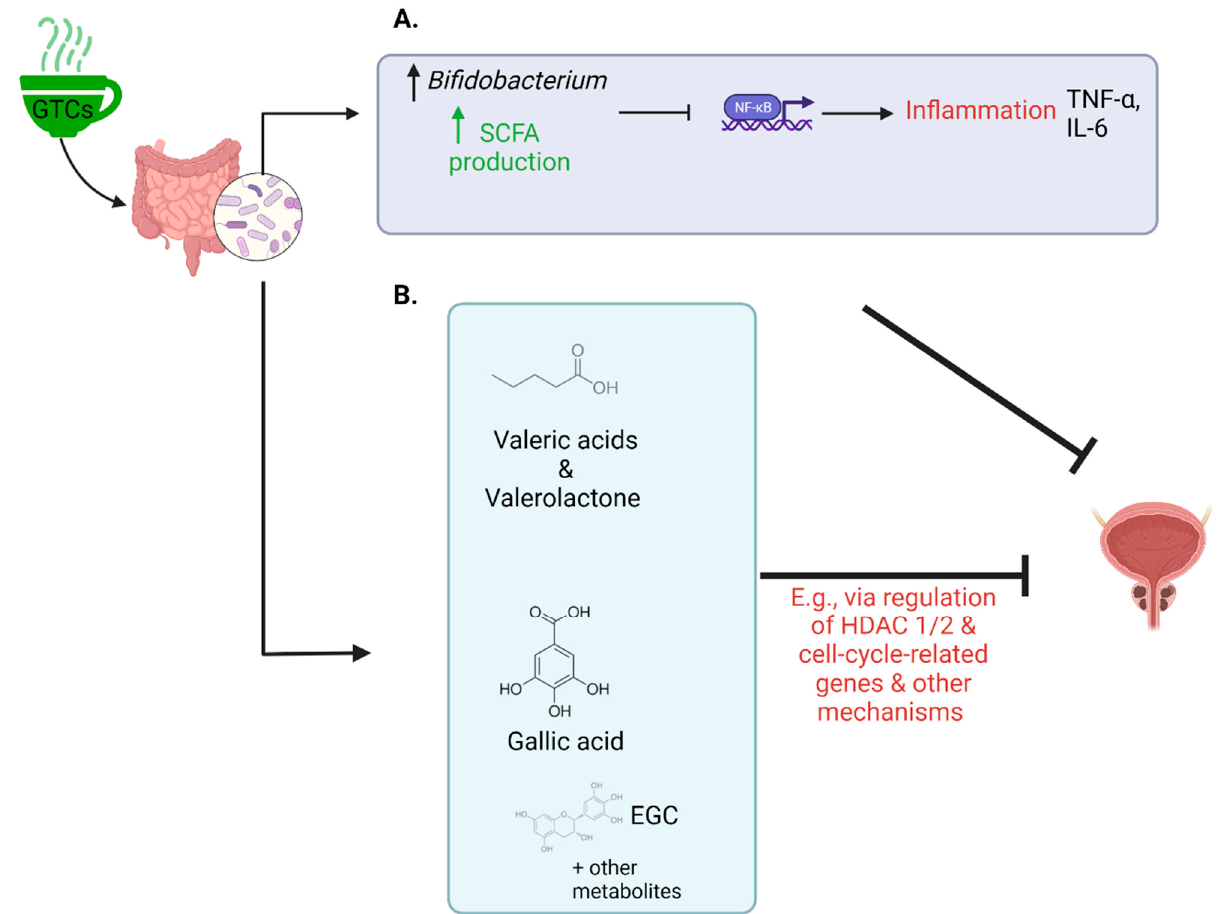
Figure 2. Examples of chemopreventive effects of GTCs in the context of PCa via gut microbiome modulation. ( A ) GTCs like EGCG have been evidenced to alter microbial composition, such as in- creasing abundance of Bifidobacterium [95]. This genus, for example, is known to increase production of SCFAs [95,96] which inhibit inflammatory pathways initiated by NF- κ B that would otherwise propel carcinogenesis [97]. ( B ) The gut microbiome can enzymatically alter GTCs like EGCG to produce metabolites including gallic acid, EGC, valeric acid, and valerolactone, that subsequently travel to the bloodstream to exert potential chemopreventive benefits (e.g., regulating HDAC 1 and 2 and suppressing cell-cycle-related genes) [95,98–100]. EGC, epigallocatechin; EGCG, epigallocatechin gallate; GTCs, green tea catechins; HDAC, histone deacetylase; IL-6, interleukin-6; NF- κ B, nuclear factor kappa B; SCFA, short chain fatty acid; TNF- α , tumor necrosis factor alpha. Created with Biorender.com (accessed on 1 July 2022).